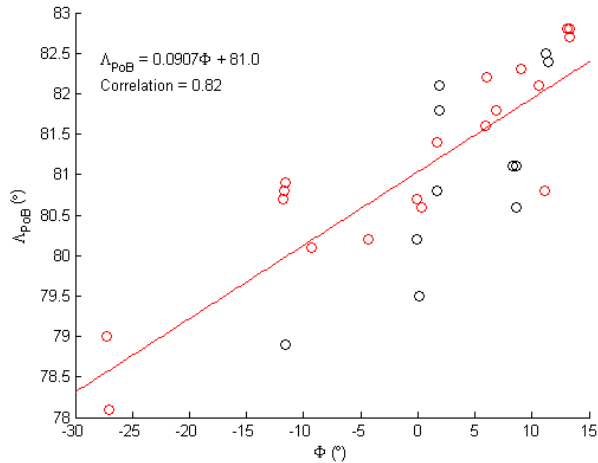
Fig. 8. Invariant latitude of the poleward cusp boundary versus dipole tilt angle for crossings corresponding to steady IMF whose clock angle is between − 45 and 45 ◦ (in GSM) and to a solar wind dynamic pressure smaller than 5nPa. Black/red dots are from cross- ings in the Northern/Southern